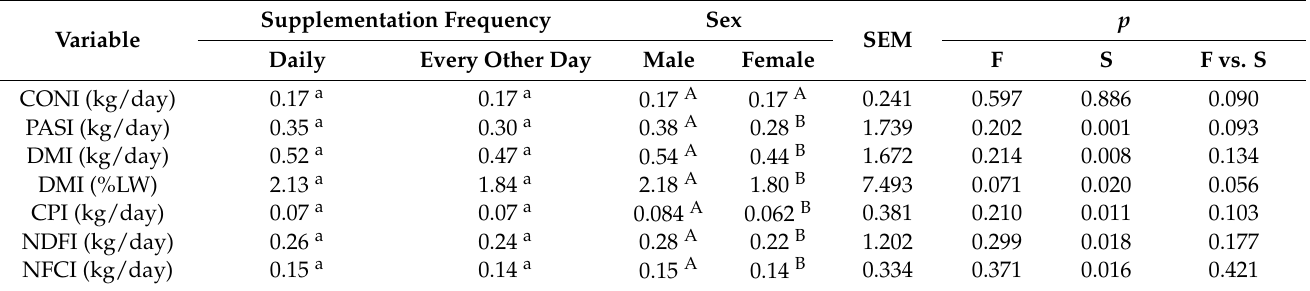
Table 2. Intake of concentrate, pasture, dry matter, and nutrients by sheep submitted to intermittent supplementation on Masai grass